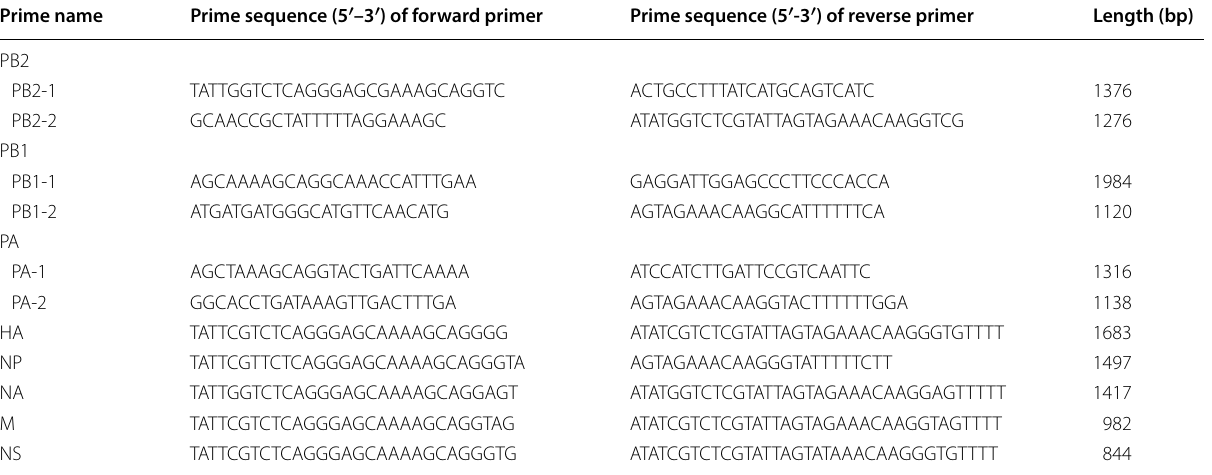
Table 1 Primer sets for amplification of the whole genome of